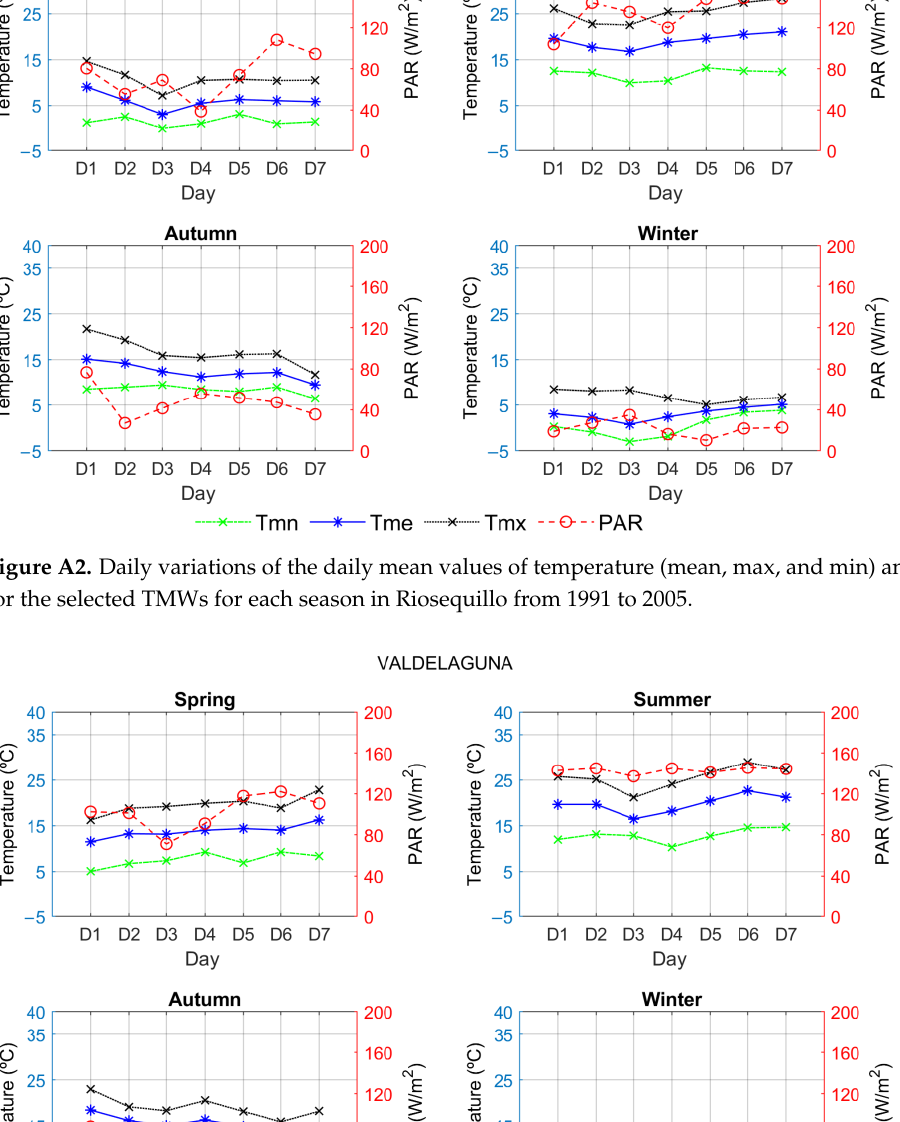
Figure A1. Daily variations of the daily mean values of temperature (mean, max, and min) and PAR for the selected TMWs for each season in Fresno-Ribatejada from 1991 to 2005.